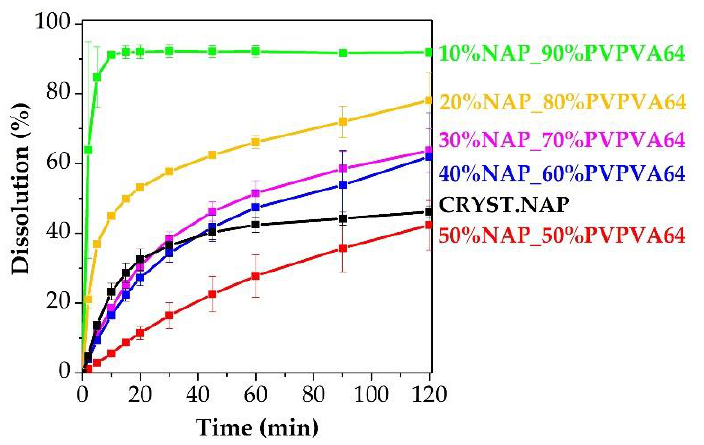
Figure 13. Dissolution results of the prepared ASDs. Applied parameters: 37 ± 0.5 °C, 900 mL of 0.1 M HCl dissolution medium, 50 mg of the API content, “tapped basket” method, 50 rpm, n = 3.